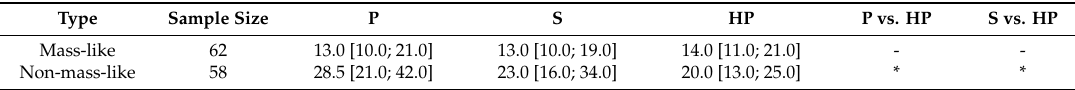
Table 4. Median and interquartile range of lesion dimensions considering mass-like and non-mass like lesions.